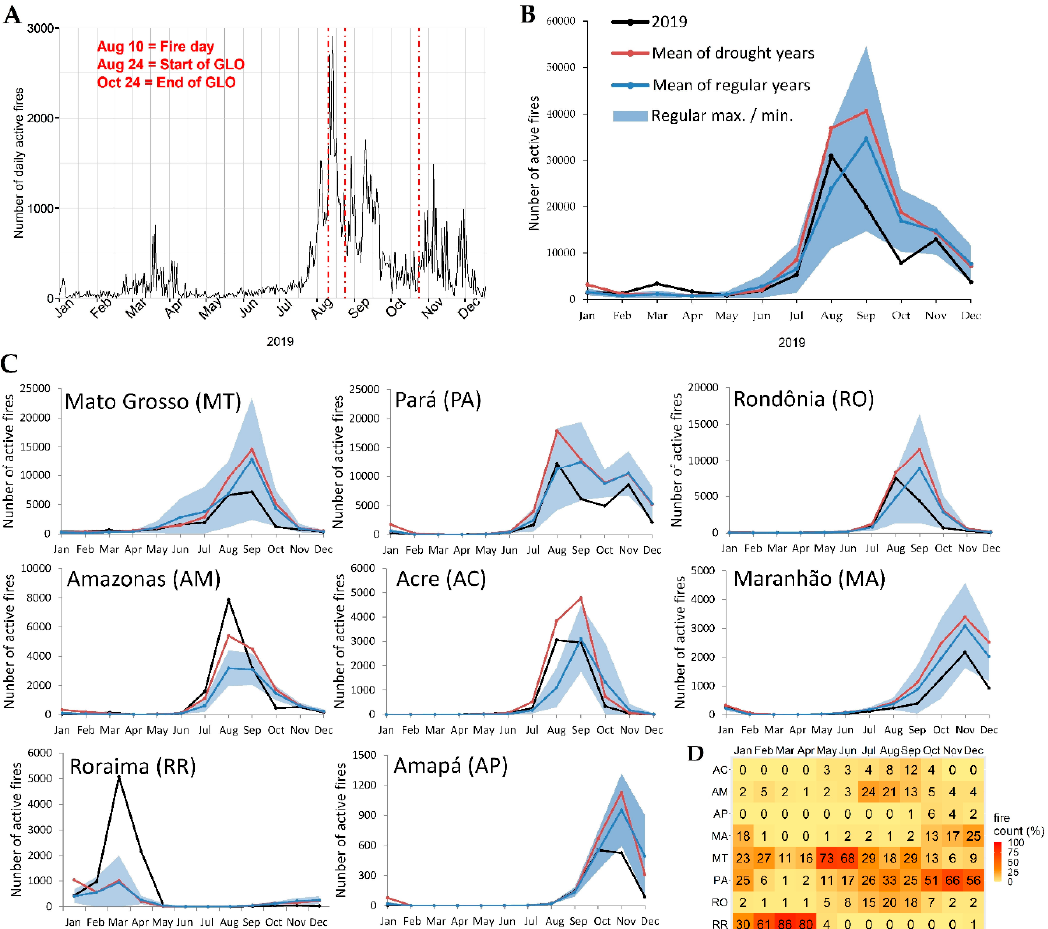
Figure 2. ( A ) Daily fire occurrence in 2019, with important dates for fire activity in the year highlighted by vertical dashed lines. On August 10, farmers and merchants coordinated a joint light of fires in which became known as the Fire Day. August 24 and October 24 marked, respectively, the start and end of the Guarantee of Law and Order (GLO), a governmental decree that authorized the use of army forces into fire combat in the Amazon. ( B ) Monthly fire occurrence in 2019 for the biome, along with the averages of extreme drought years (2005, 2010, and 2015–2016) and regular years from 2003 to 2018, and the range of regular years. ( C ) Similar to (B), but for Amazonian states. ( D ) The percentage shared by each state in total monthly fire occurrence in 2019.